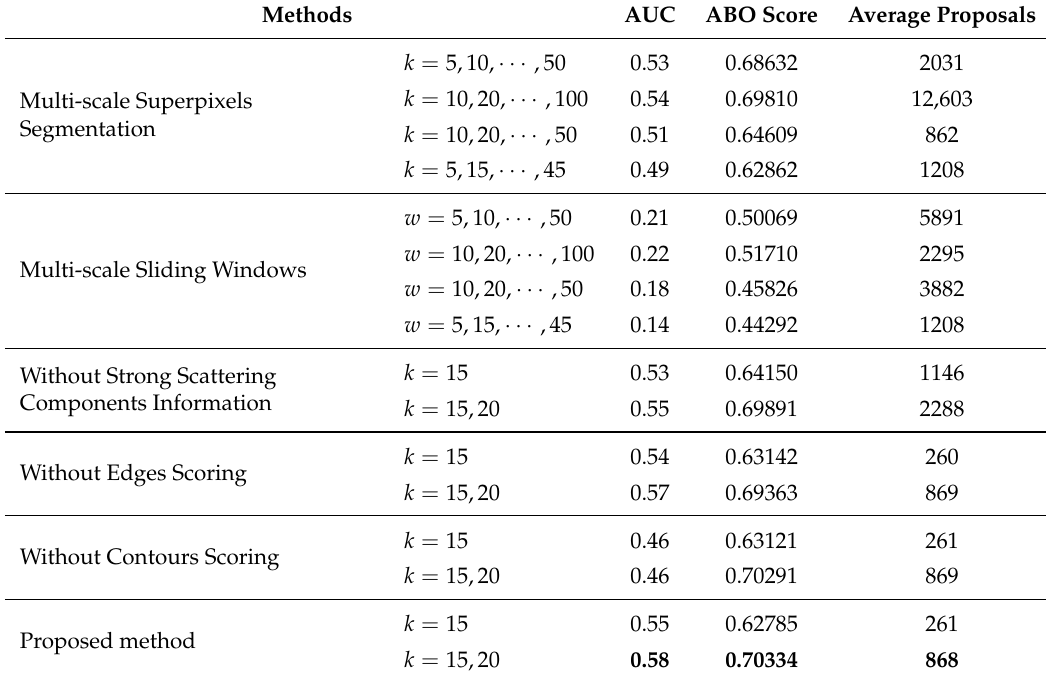
Table 1. The average best overlap (ABO) scores, the area under the curve (AUC) and average number of ship proposals for the proposed approach and various variants of our approach.